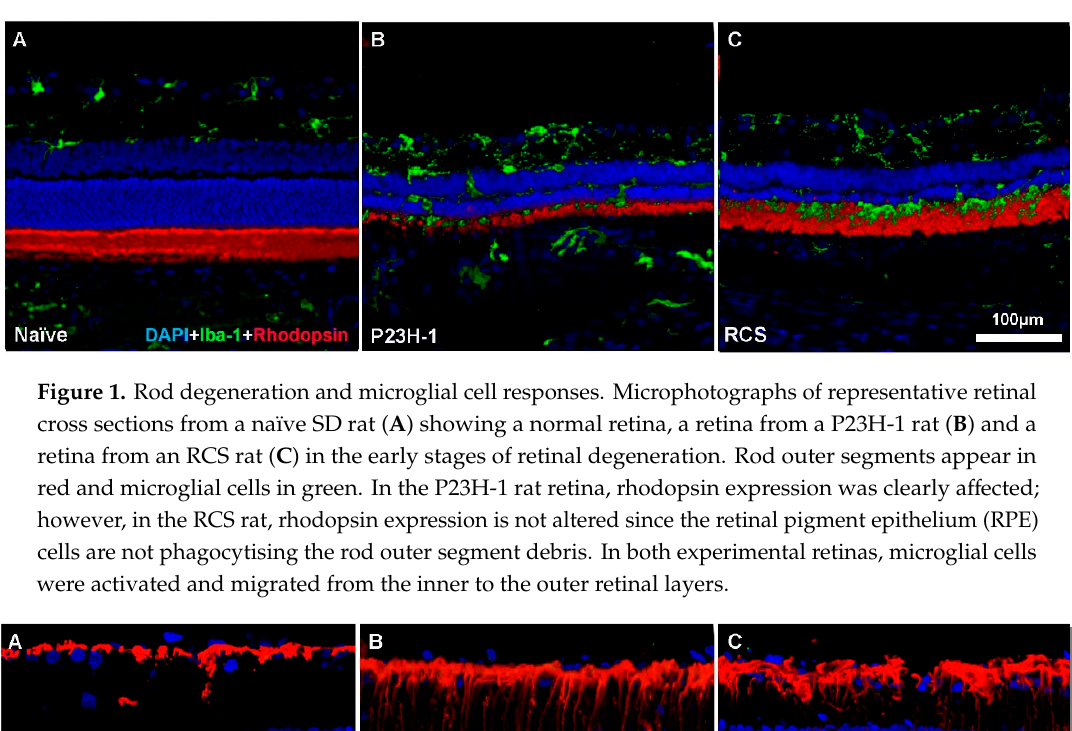
Figure 1. Rod degeneration and microglial cell responses. Microphotographs of representative retinal cross sections from a naïve SD rat ( A ) showing a normal retina, a retina from a P23H-1 rat ( B ) and a retina from an RCS rat ( C ) in the early stages of retinal degeneration. Rod outer segments appear in red and microglial cells in green. In the P23H-1 rat retina, rhodopsin expression was clearly affected; however, in the RCS rat, rhodopsin expression is not altered since the retinal pigment epithelium (RPE) cells are not phagocytising the rod outer segment debris. In both experimental retinas, microglial cells were activated and migrated from the inner to the outer retinal layers.